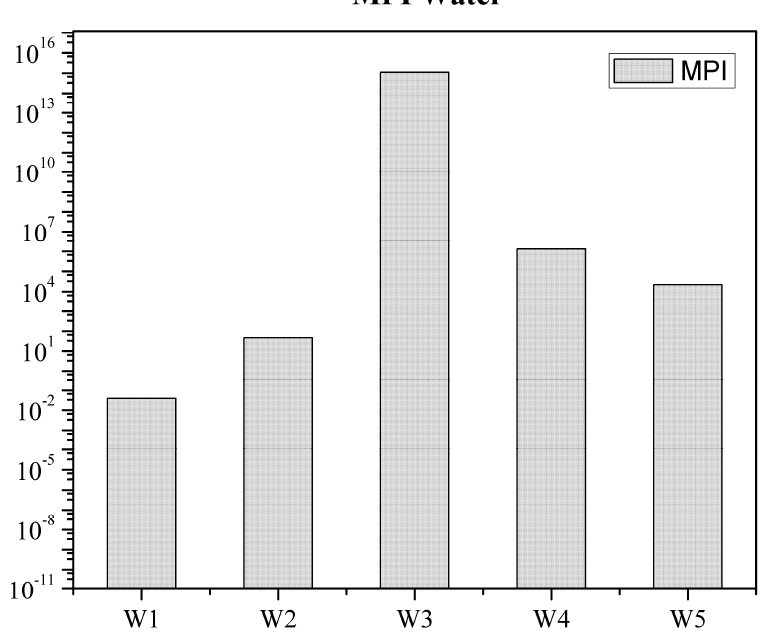
Figure 2. Metal pollution index (MPI) for water each sampling station.